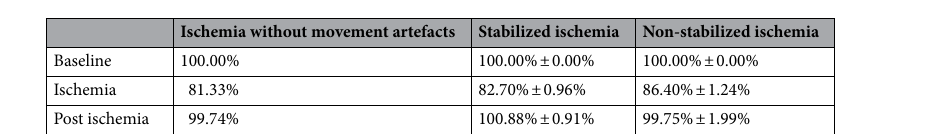
Figure 4. ( A ) The unprocessed image of the flow phantom (top) and ex vivo kidney (bottom). ( B ) Perfusion images of the stationary flow fantom (top) and ex vivo kidney (bottom) displayed in laser speckle perfusion units (LSPU) [A.U.]. ( C ) Perfusion image (the same as D ) of non-stationary flow phantom (top) and ex vivo kidney (bottom) using the traditional laser speckle contrast imaging (LSCI) mode in LSPU [A.U.]. D: Perfusion image (the same as C ) of non-stationary flow phantom (top) and ex vivo kidney (bottom) using the multi- spectral motion correction and compensation LSCI model in LSPU[A.U.].